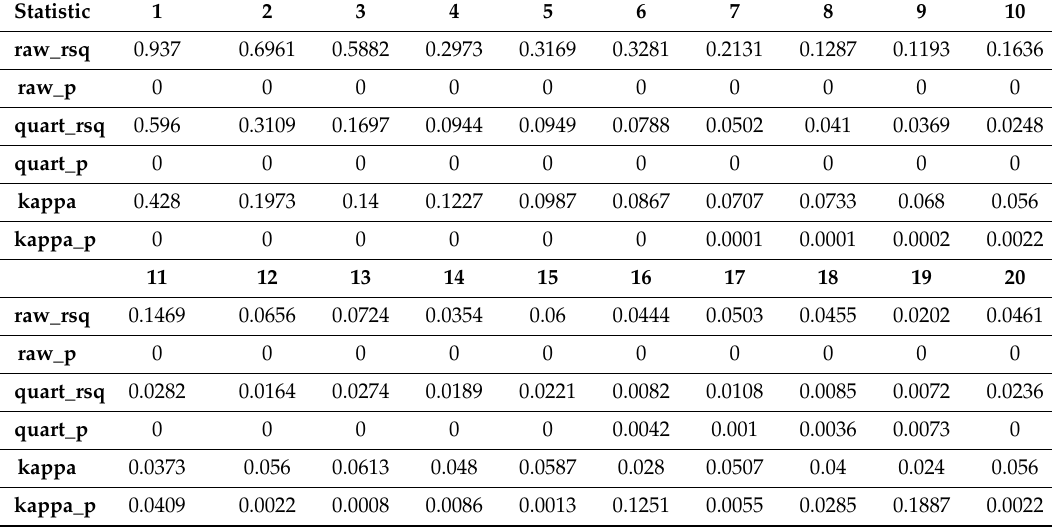
Table 1. Results from statistical tests on log-normally distributed data ( n = 1000), comparing determination coe ffi cients (r 2 = “rsq”) and p-values of raw data with those of quartile-transformed data and the Kappa-statistic of those data. Columns represent the white noise level added to the raw data to create a correlated data set to be compared with the original. In this case, the third column represents a white noise level slightly larger than the SD of the data, while the last column (20) represents a noise level approximately ten-times one